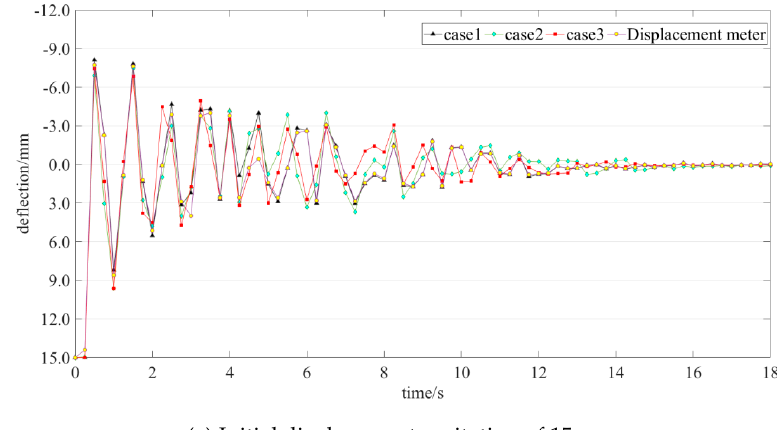
Table 4. Correlation coefficients between different cases and the reference.